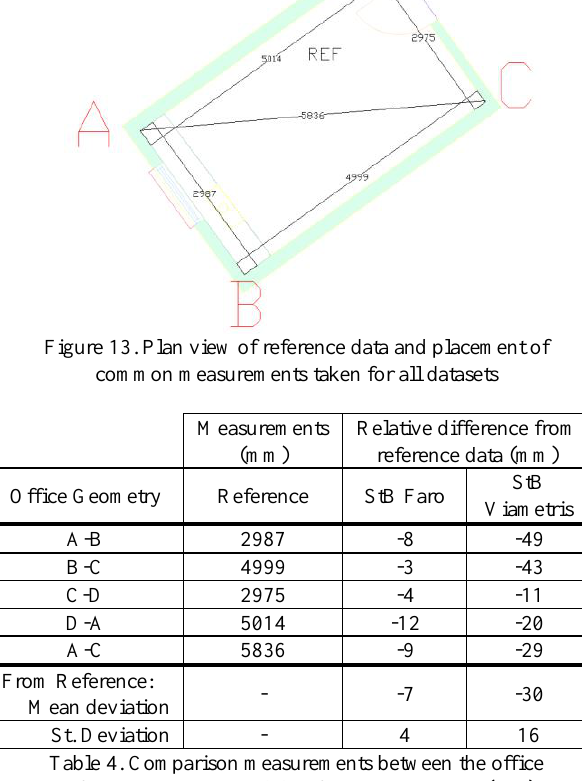
Table 4. Comparison measurements between the office reference geometry and that from Scan to BIM